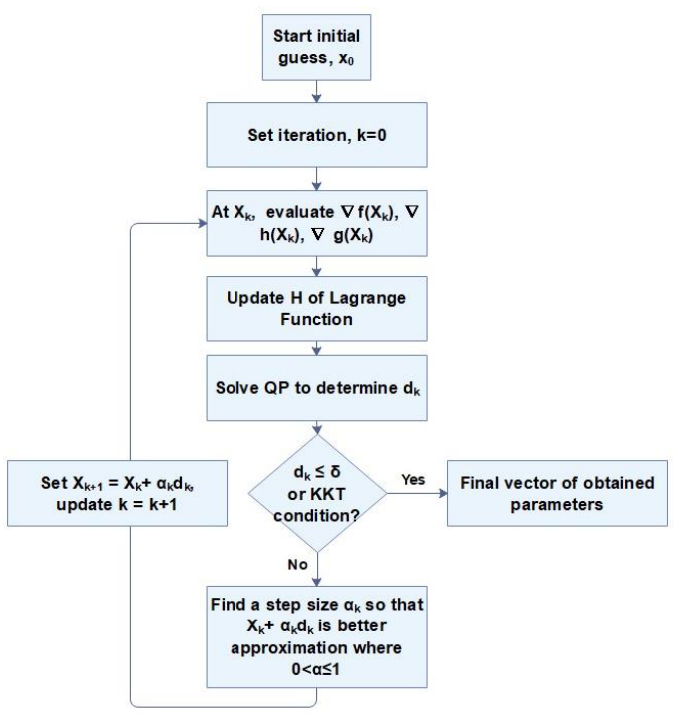
Figure 2. The iterative flowchart of the quadratic programming algorithm (SQP) method [38].